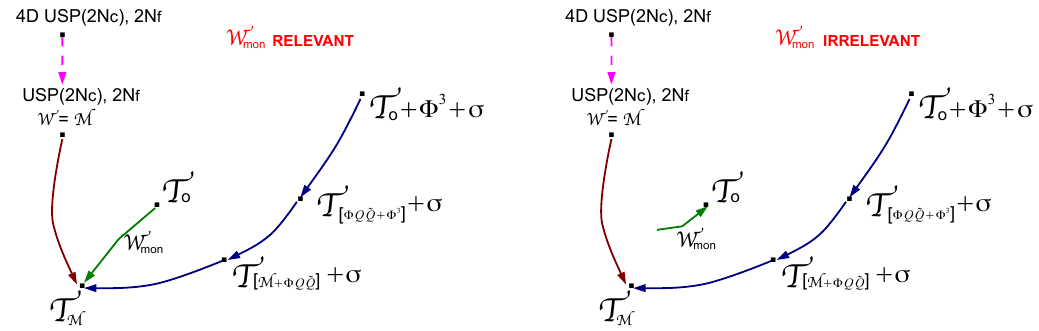
Figure 1 . Schematic structure of RG (cid:13)ows that can lead to T M . The pink (cid:13)ow is a 4D ! 3D reduction on S 1 , while the red (cid:13)ow is a real mass deformation. The green (cid:13)ow is a deformation of T 0 by W mon , which is relevant on the left but irrelevant on the right (and therefore it does not leave T 0 ). The blue (cid:13)ow involves more degrees of freedom: the Ising-SCFT and extra free (cid:12)elds (see section